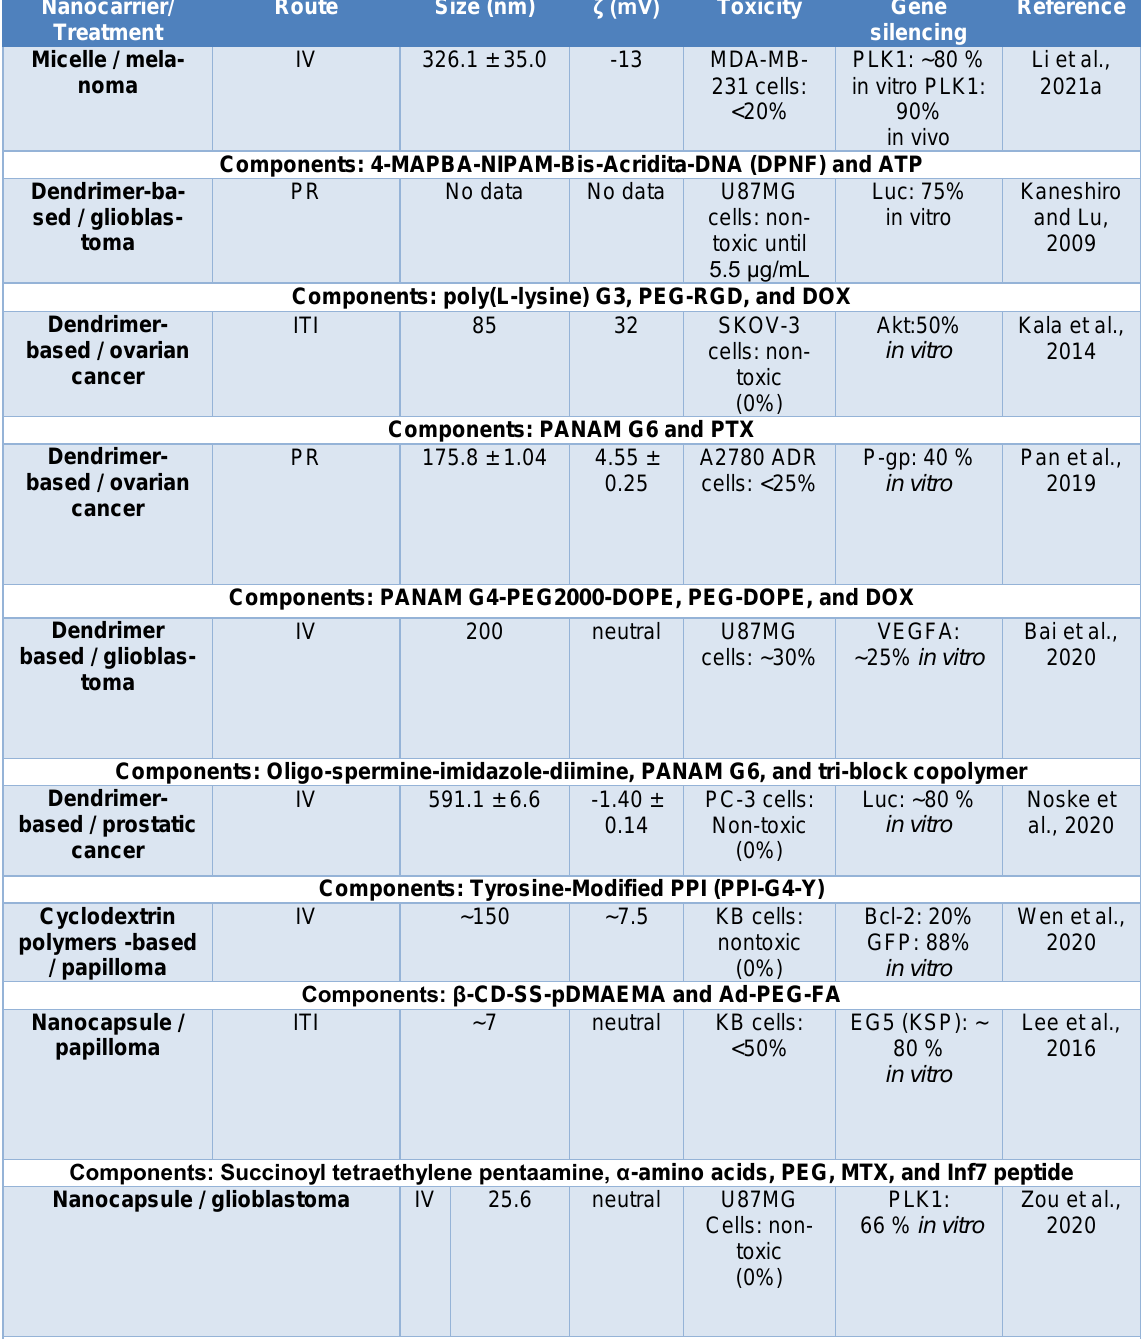
Table 3 (cont.): Nanocarriers composed of miscellaneous polymeric nanoparticles